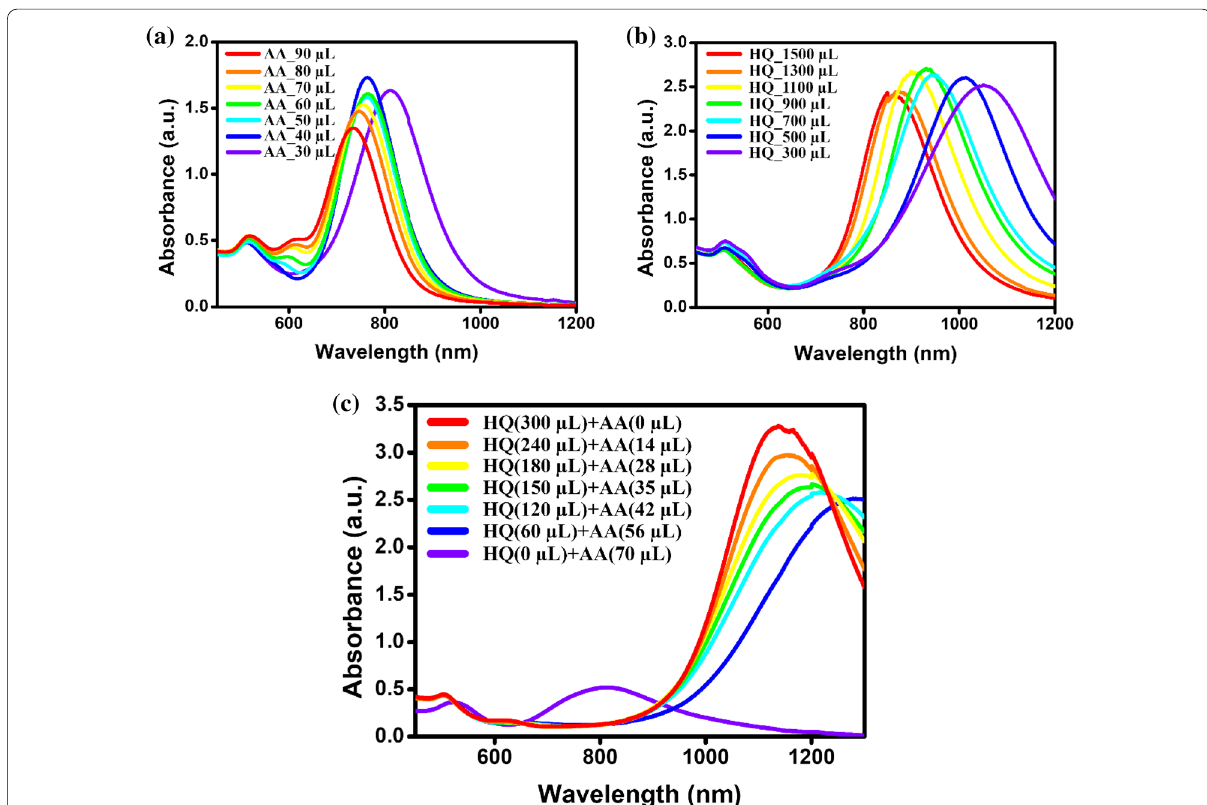
Fig. 2 Absorption spectra of Au NRs synthesized by controlling the volume of a AA and b HQ as reducing agents. c Absorbance spectra of Au NRs prepared under the combined effect of HQ and AA, mixed at different volume